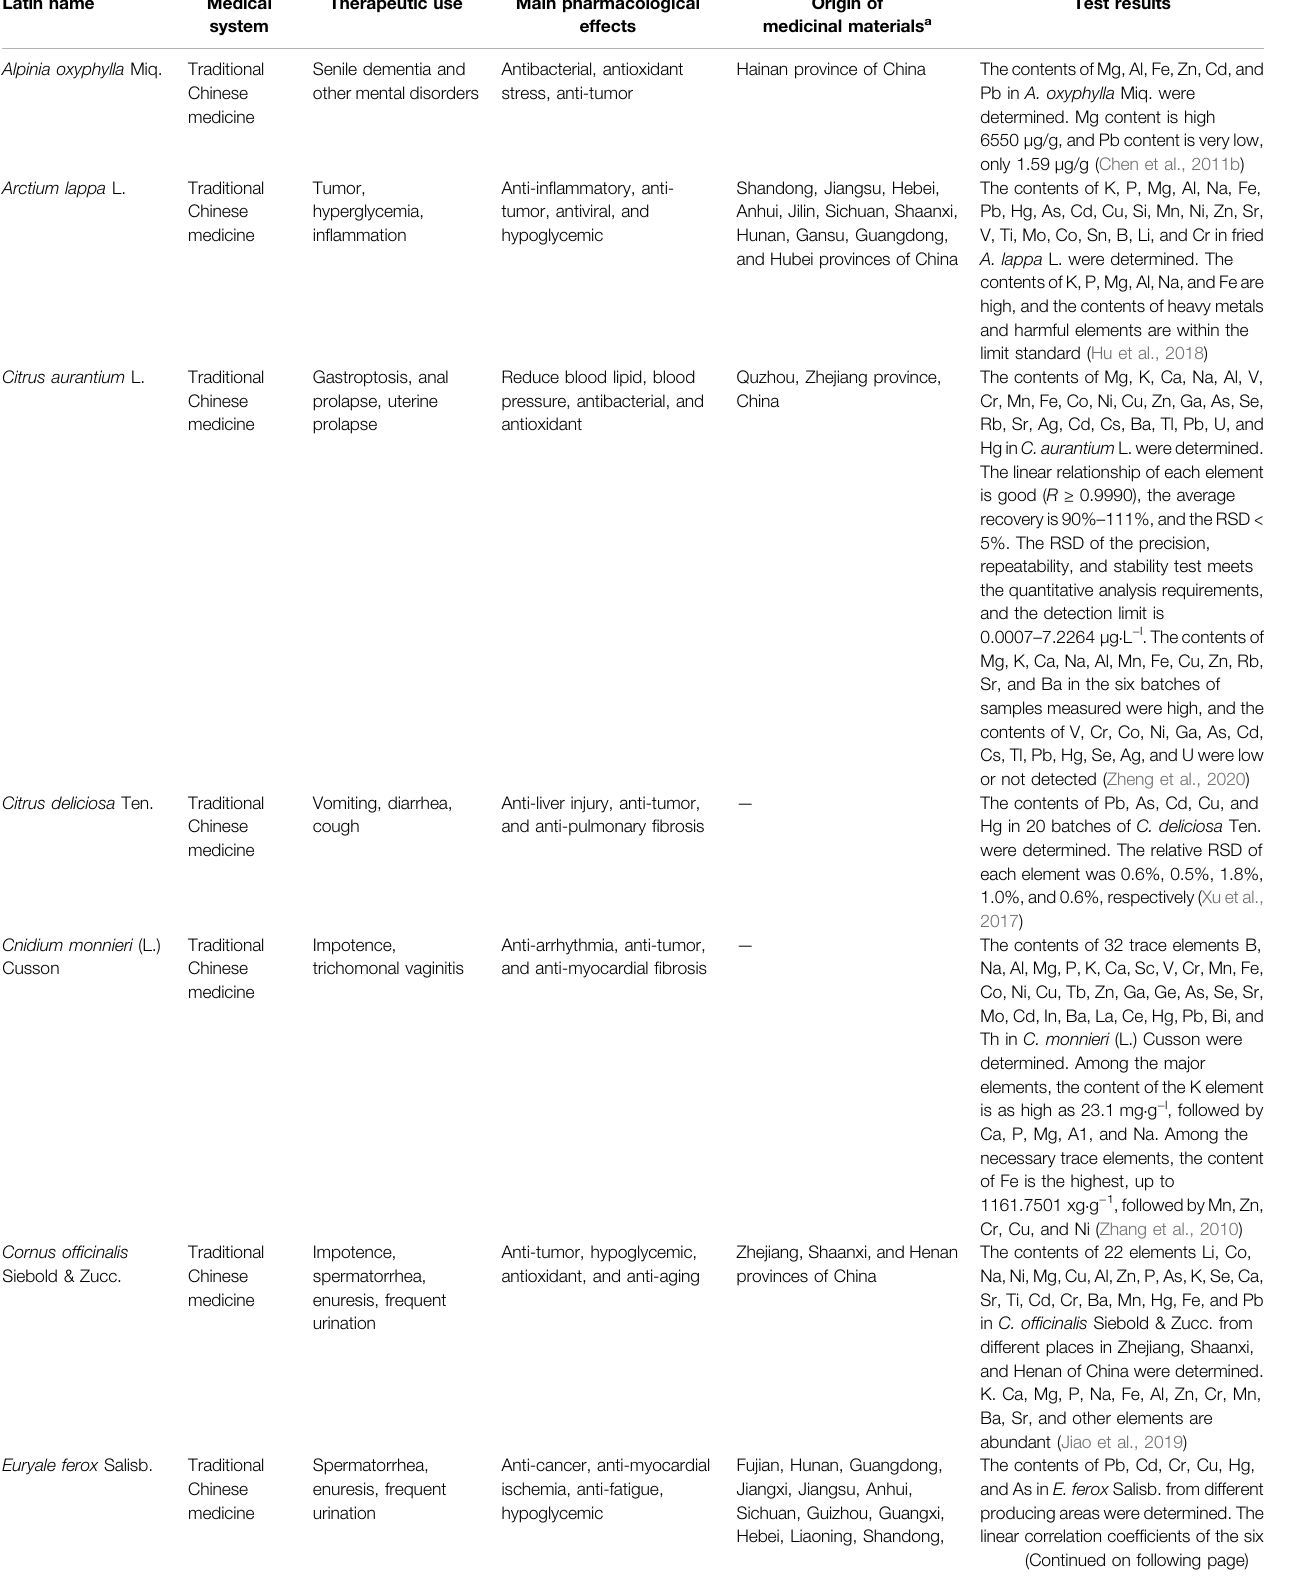
TABLE 5 | Application of ICP-MS in the determination of heavy metal elements in medicinal materials derived from the fruits and seeds of plants. Latin